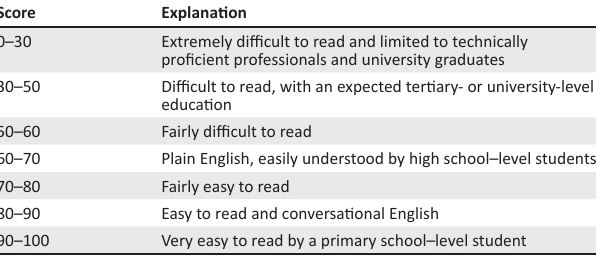
TABLE 2: Flesch Reading Ease score